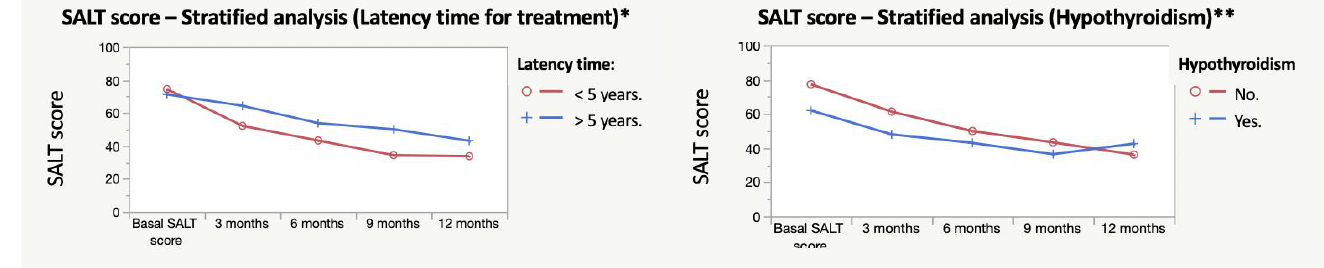
Figure 3. Stratified analyses for latency time for treatment and hypothyroidism did not find significant differences between groups.